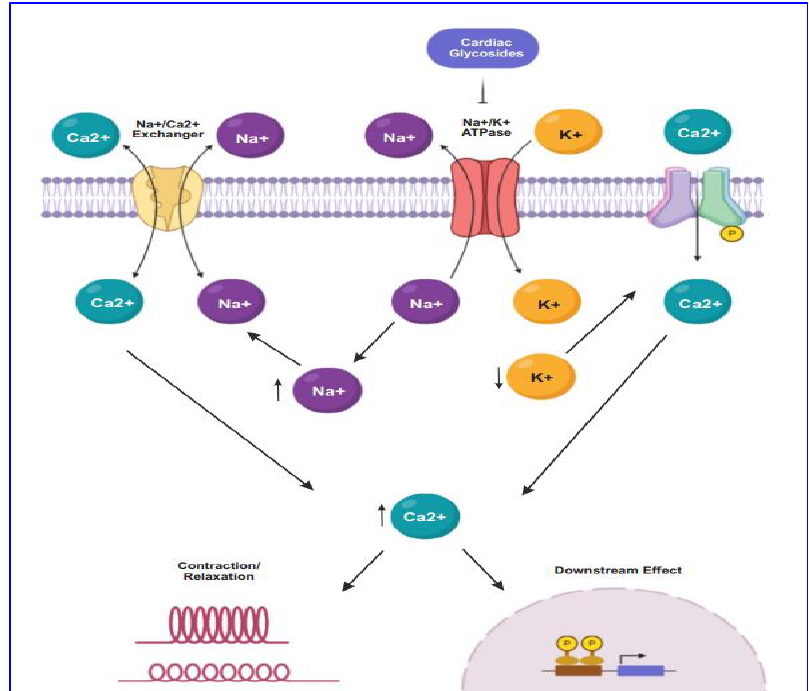
Figure 1. The mode of action of CGs in cancer proceeds through targeting Na + /K + -ATPase by maintaining the concentration of sodium-potassium gradient across the plasma membrane. CG binds to the Na + /K + -ATPase pump, thus inhibiting it, resulting in intracellular retention of Na + and increasing the concentration of Ca 2+ . Subsequently, lower expression of Na + /K + -ATPase causes endoplasmic reticulum stress.